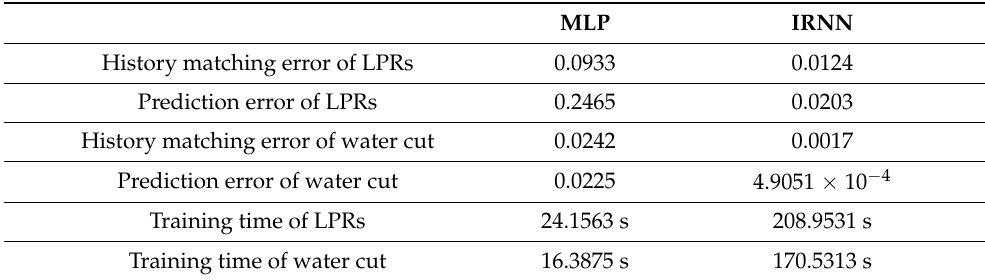
Table 3. The computation error (MSE) and time (seconds) of both MLP and IRNN of the three- channel